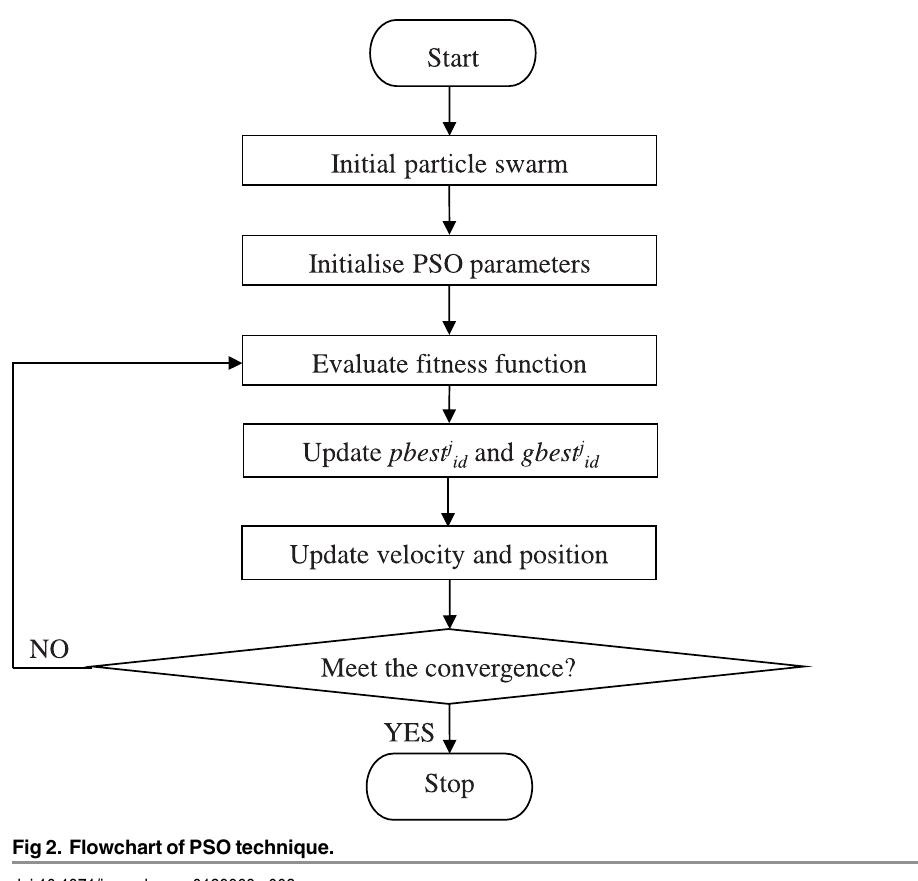
Fig 2. Flowchart of PSO technique.